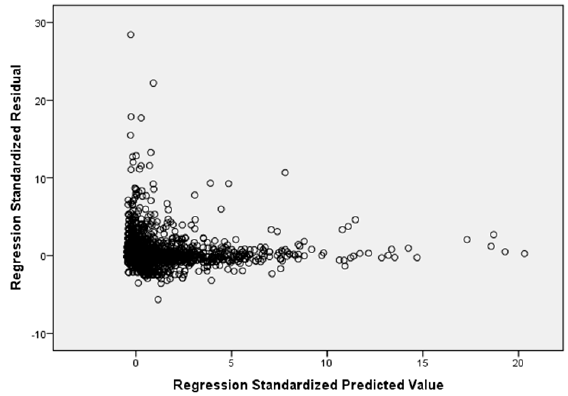
Figure 4. “Standardized expected value regression” vs. “Standardized residual regression” of the multiple linear regression model.